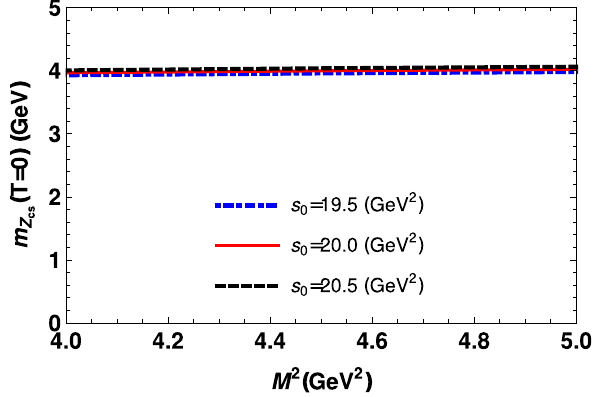
Fig. 1 The vacuum mass of the Z cs state versus Borel parameter M 2 for fixed continuum threshold values in the tetraquark